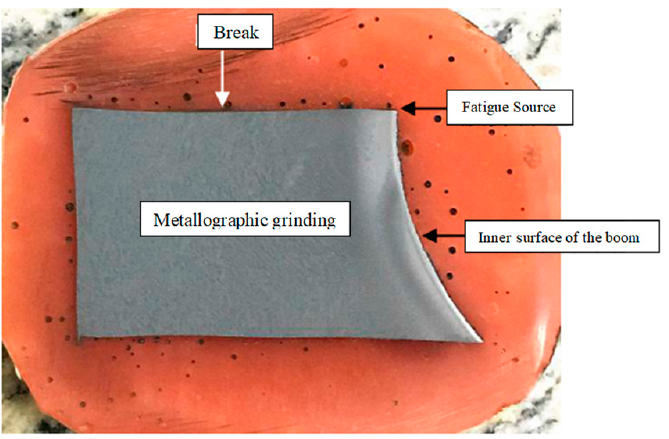
Figure 5. The macroscopic metallographic surface of the origin of the boom fracture sent for inspec- tion.